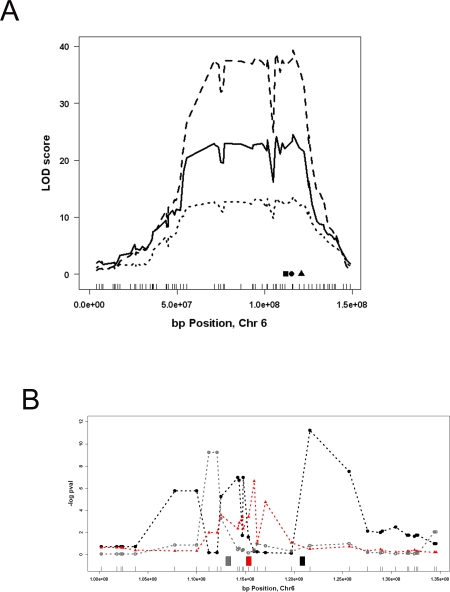
Comparison of the three conserved local eQTL on chromosome 6 between the BxH and MF1 studies.Panel (A) shows the BxH mapping results for Pparg (dashed curve), Cidec (solid curve), and Bcl2l13 (dotted curve). The physical location of Pparg (circle), Cidec (square), and Bcl2l13 (triangle) is shown at the bottom. Panel (B) shows the MF1 results for Pparg (solid triangles with dotted red curve), Cidec (open circles with gray dotted curve), and Bcl2l13 (solid circles with dotted black curve). The physical location of the genes are depicted at the bottom with gray box for Cidec, red box for Pparg, and black box for Bcl2l13. Tick marks on x-axis depict the physical location of the markers in the BxH dataset.